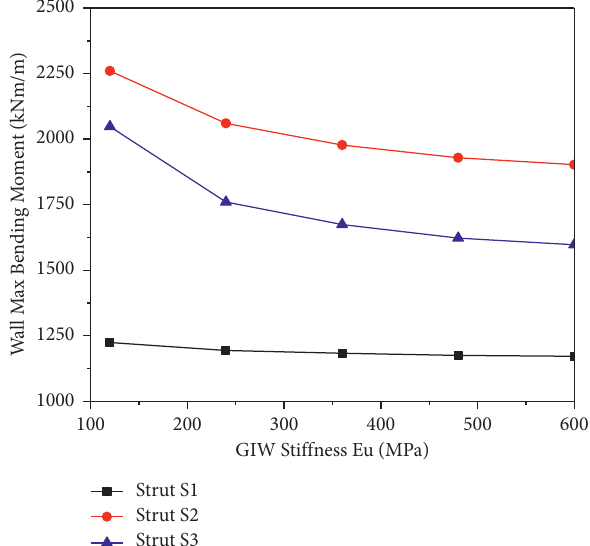
Figure 16: The effect of ground improvement Eu on strut